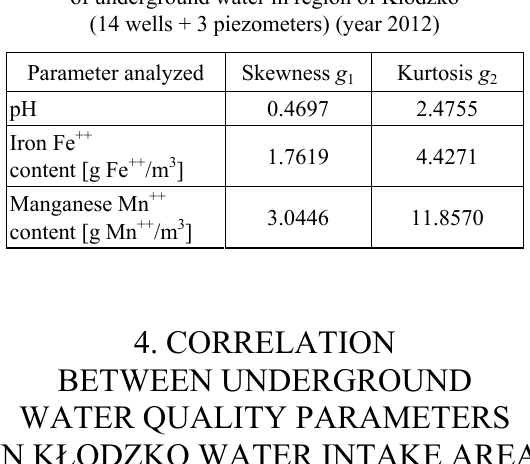
Table 7. A comparison of values of skewness g 1 and kurtosis g 2 of distributions histograms of quality parameters of underground water in region of Kłodzko